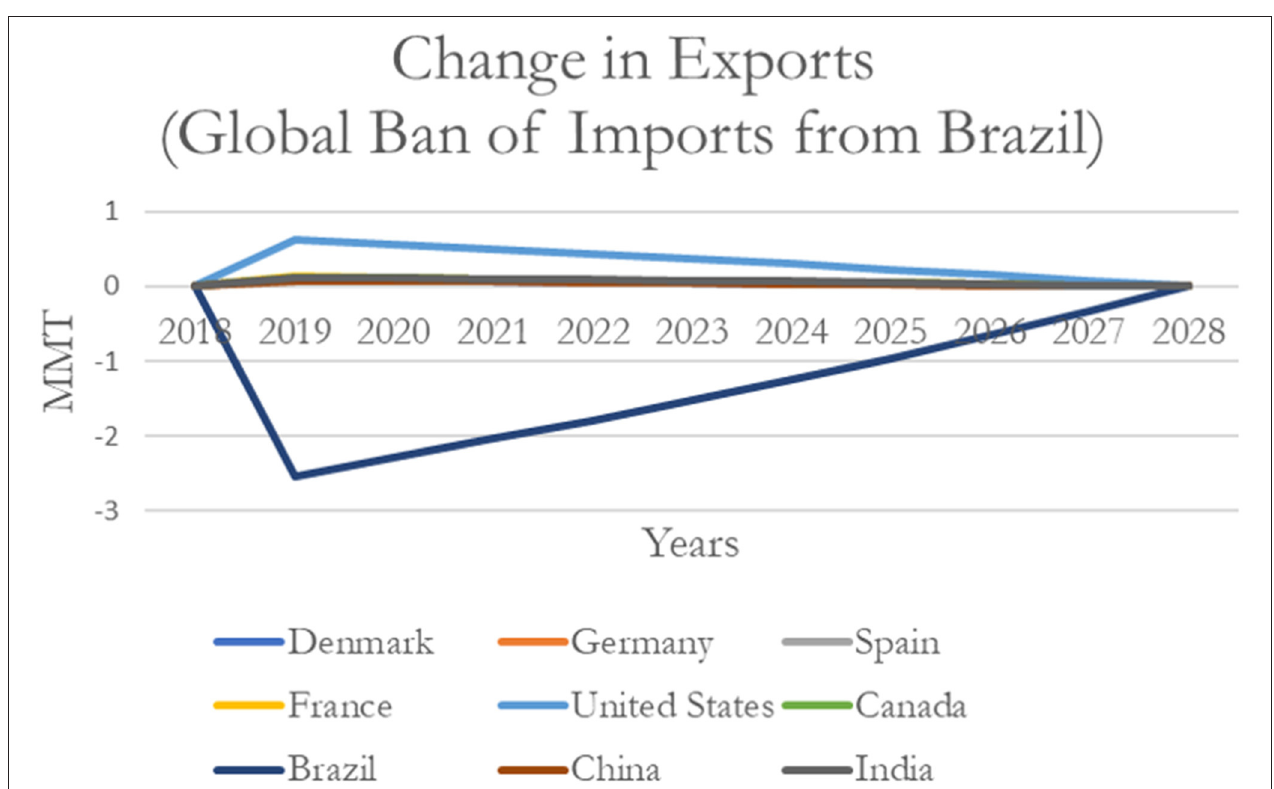
FIGURE 4 | Change in meat exports in million metric tons (MMT) of select countries. The U.S. increases its exports its exports the most in response to the ban of imports from Brazil in 2019. As Brazil is gradually allowed access to international markets, Brazil’s exports recover and exports of other major exporters gradually